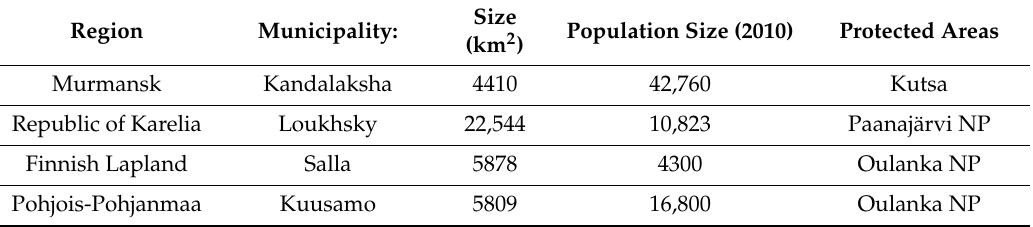
Table 1. Characteristics of administrative units in the Kovda River